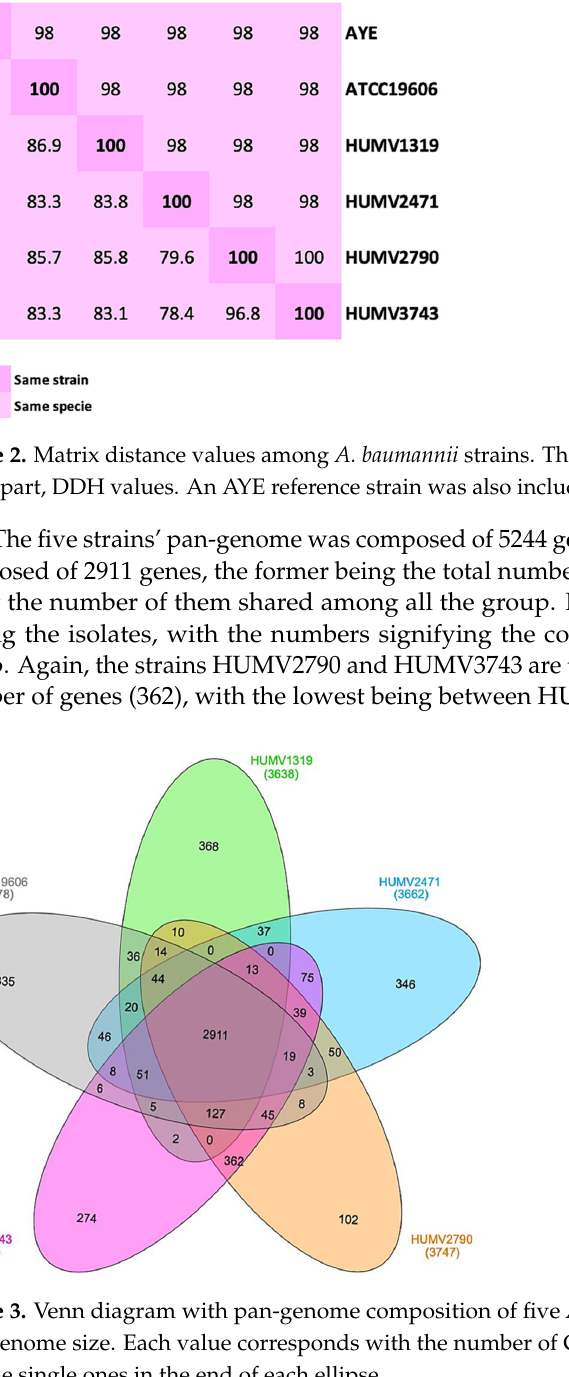
Figure 1. Protein-coding sequences included in each subsystem category . Each bar shows the aver- age of five strains ± SE (standard error).